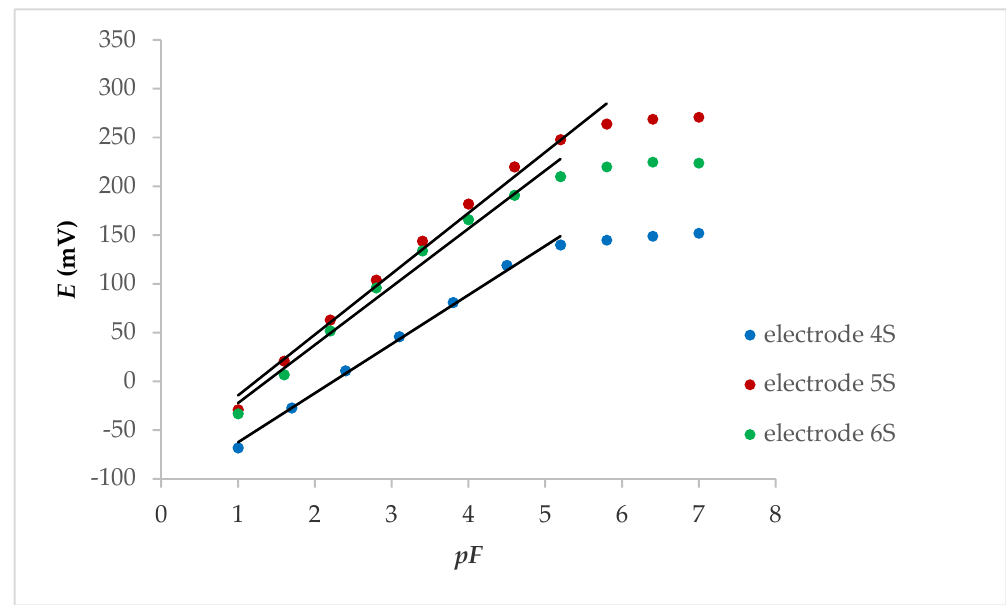
Figure 1. Potentiometric response of internal solid contact LaF 3 electrodes with Fe x O y NPs.